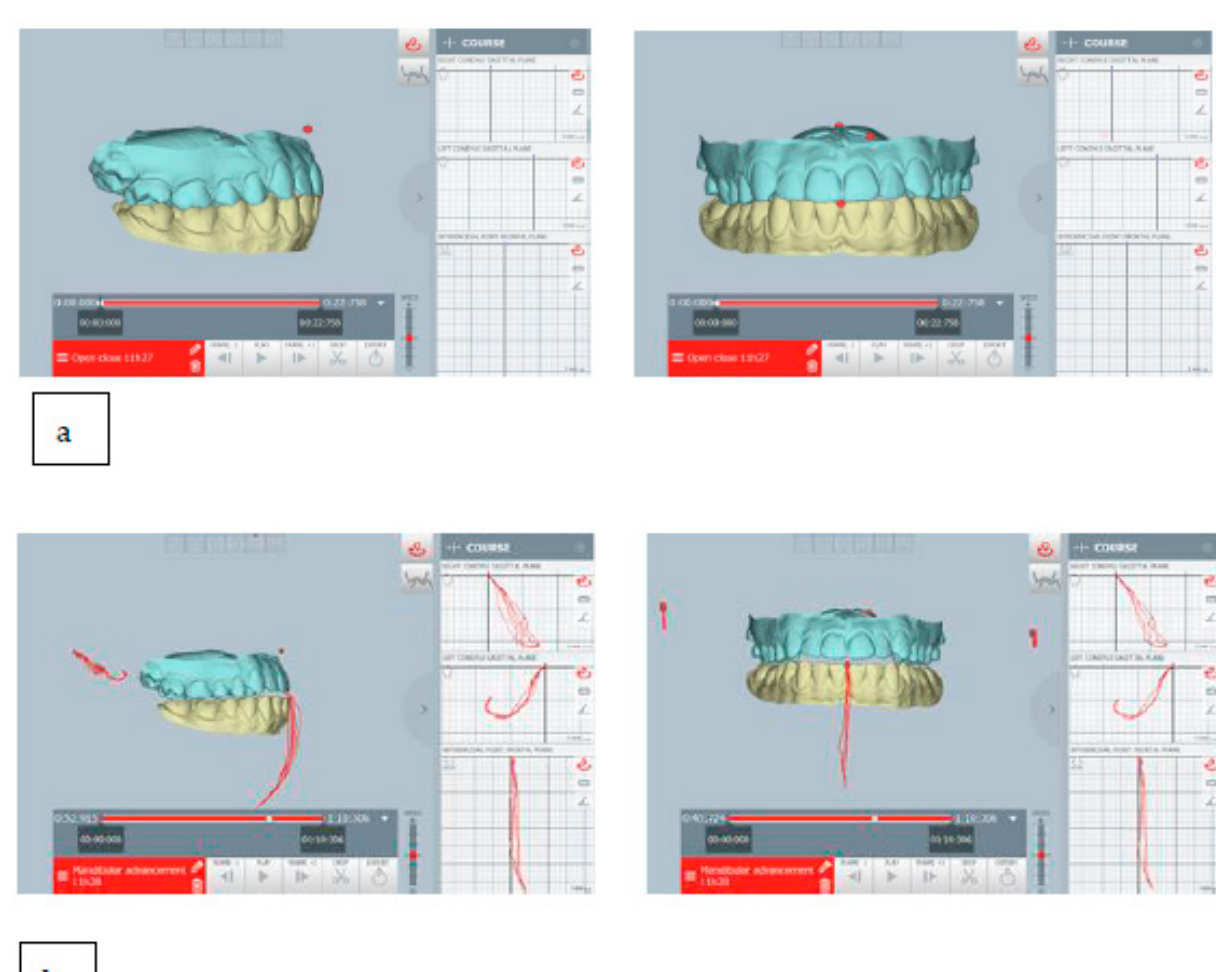
Figure 22. ( a ) The habitual occlusion position; ( b ) mandibular repositioning for intraoral appliance; ModJaw allowed to evaluate of kinematic tracings of the condyle from the therapeutic position. The mandible was repositioned forward about 2 mm and downward about 1